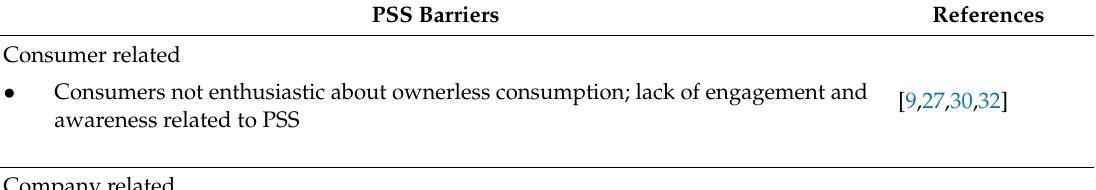
Table 2. Summary of PSS barriers to